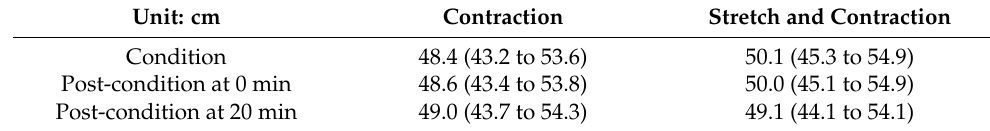
Table 3. Change in two-legged countermovement maximal vertical jump height.